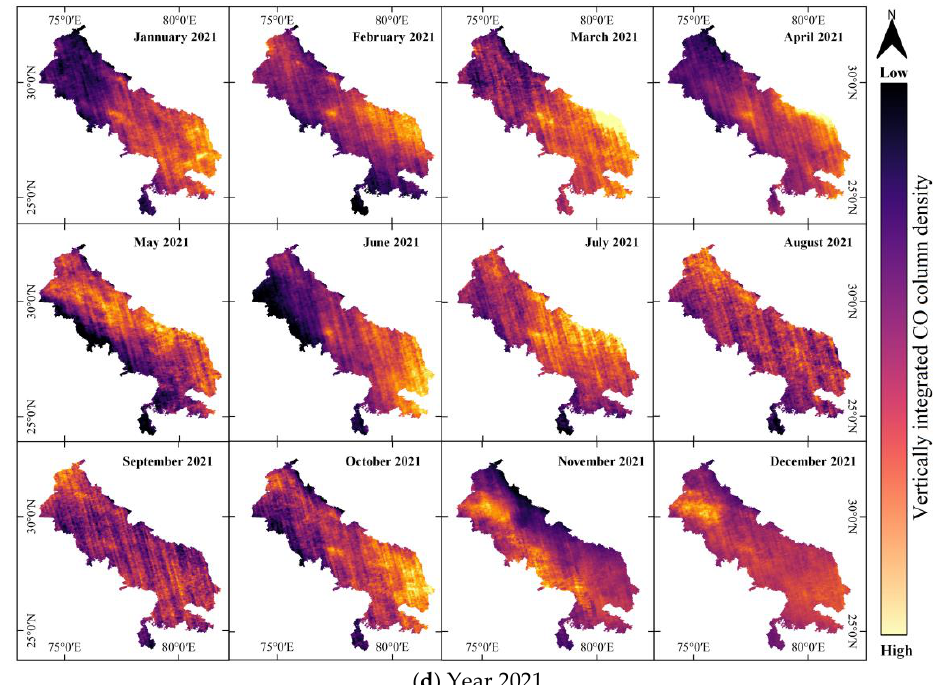
Figure 6. Atmospheric CO concentration over the study site (June 2018 to December 2021).